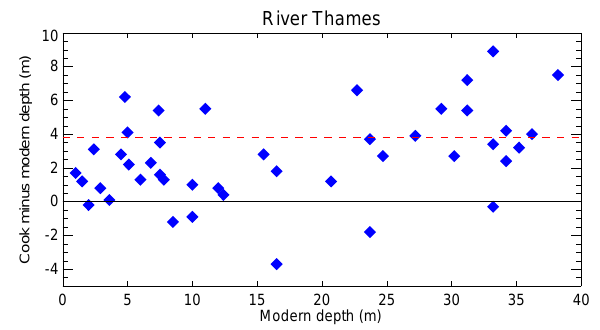
Figure 7. Differences between depths measured by Cook and those obtained from modern soundings at River Thames. Positive val- ues indicate that Cook’s depths were greater than modern values. Cook’s values will have included the height of the tide at the time, whereas the modern depths are expressed relative to sounding da- tum (within a few centimetres of Lowest Astronomical Tide). The maximum height of the tide above sounding datum during the pe- riod that Cook was at River Thames is indicated by the red dashed